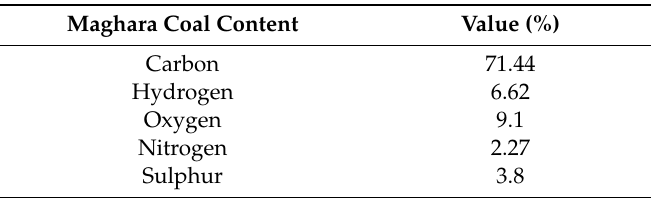
Table 2. Chemical analysis of Maghara